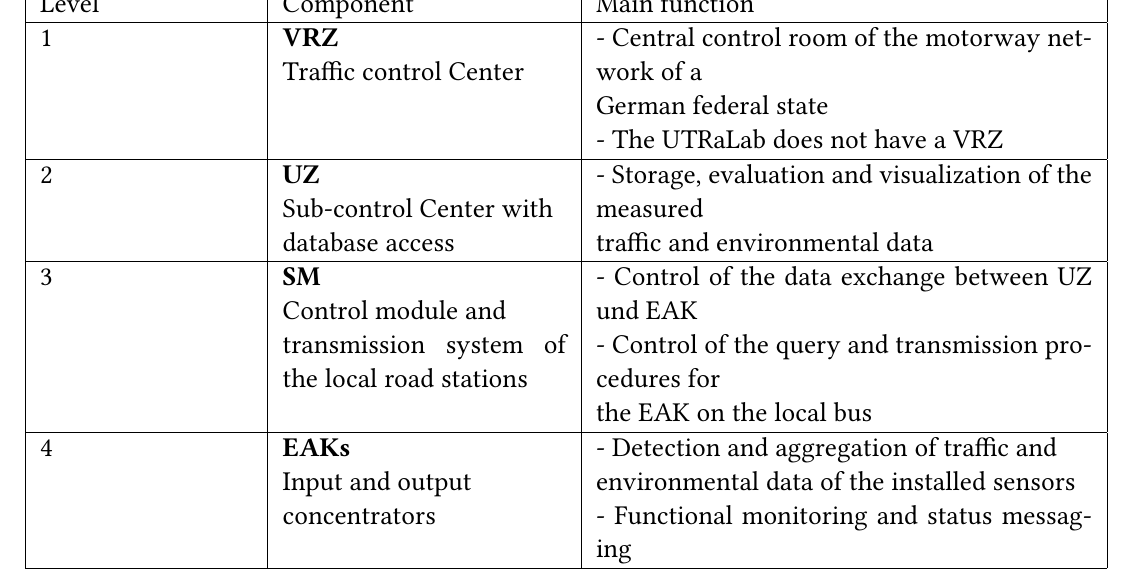
Table 1: Description of the UTRaLab